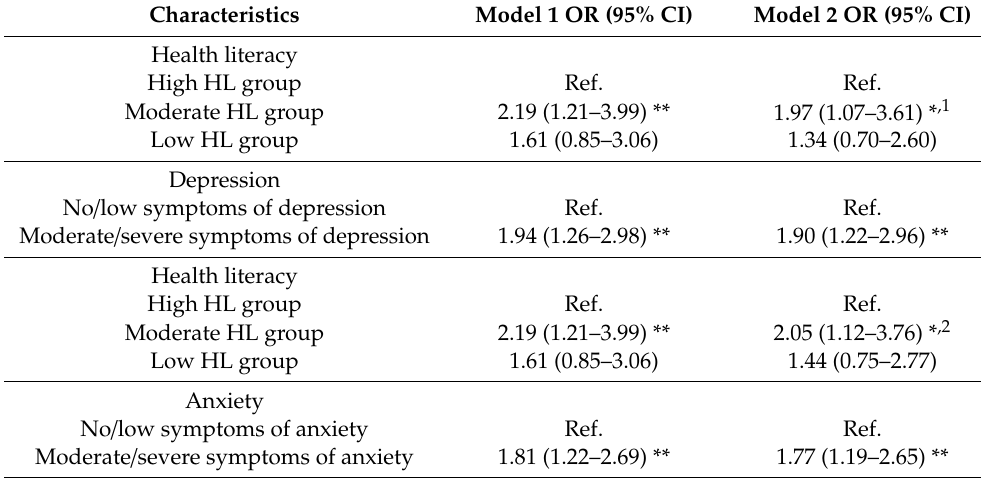
Table 3. The association of health literacy, depression and anxiety with diet non-adherence (Model 1) and the mediating e ff ect (Model 2) of depression and anxiety in relation to HL and diet non-adherence. Logistic regression adjusted for age and gender ( n =